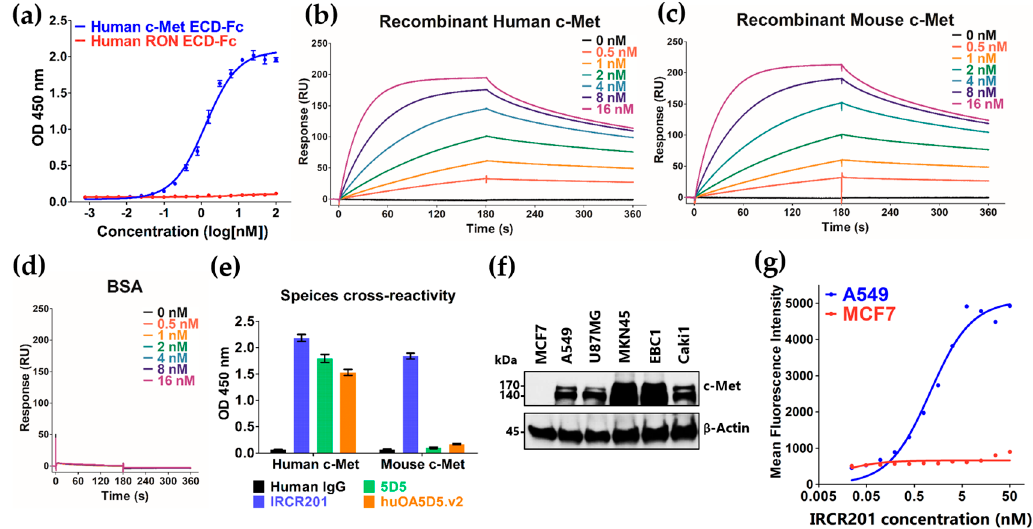
Figure 1. Binding properties of IRCR201. ( a ) Binding patterns of IRCR201 to the human c-Met extracellular domain (ECD)-fragment crystallizable region (Fc) and the human RON (recepteur d’origine nantais) ECD-Fc were measured by enzyme-linked immunosorbent assay (ELISA). IRCR201 binds to the human c-Met ECD-Fc with specificity and selectivity; ( b – d ) Surface plasmon resonance (SPR) sensorgrams binding with varying concentrations of IRCR201 to human c-Met, mouse c-Met, or bovine serum albumin (BSA) immobilized onto a CM5 Biacore TM sensor chip; ( e ) Cross-reactivity analysis of IRCR201 to human and mouse c-Met; ( f ) Analysis of c-Met expression in various types of cancer cell lines; ( g ) Binding analysis of IRCR201 to the cell surface c-Met through a flow cytometer (FACSAria™ III).